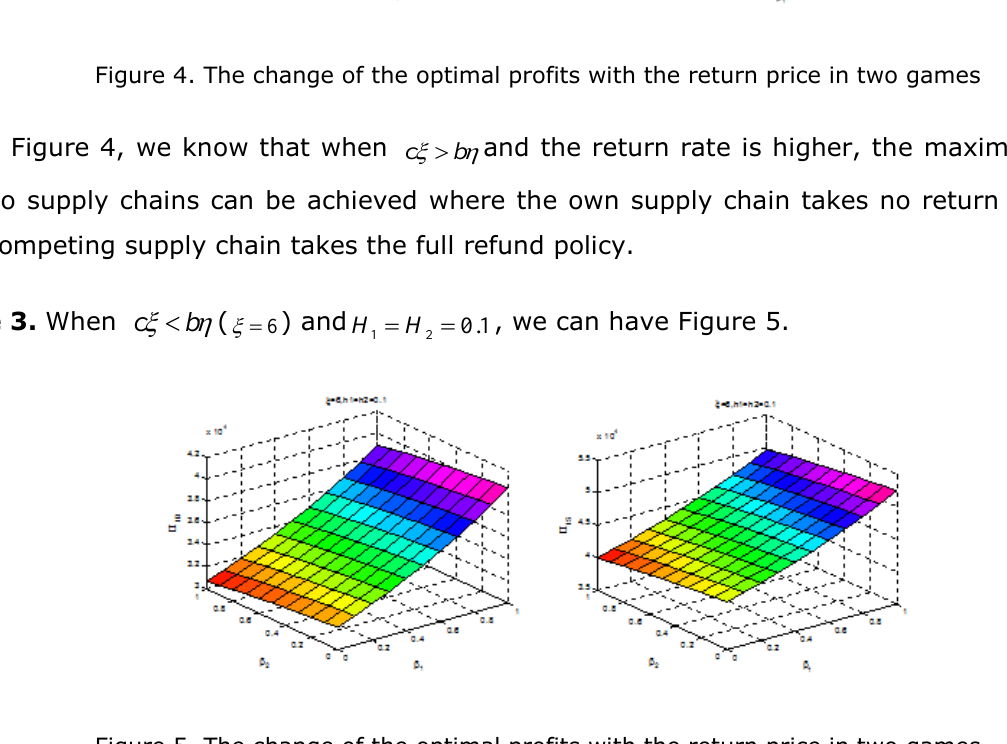
Figure 5. The change of the optimal profits with the return price in two games From Figure 5, we know that when c b   and the return rate is lower, the maximum profits of two supply chains can be achieved where the own supply chain takes full refund policy and the competing supply chain takes no return